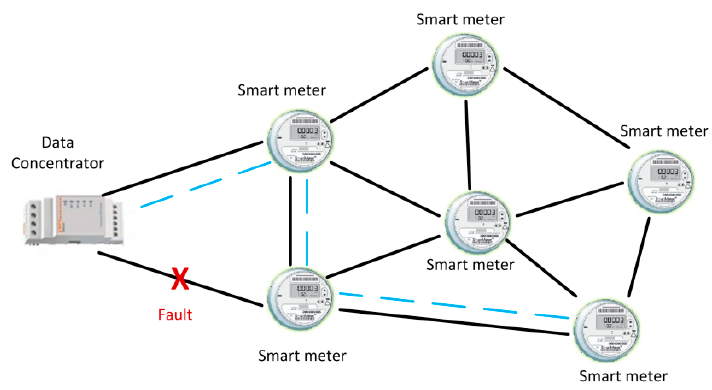
Figure 2. Smart meters forming a mesh network for data transmission.